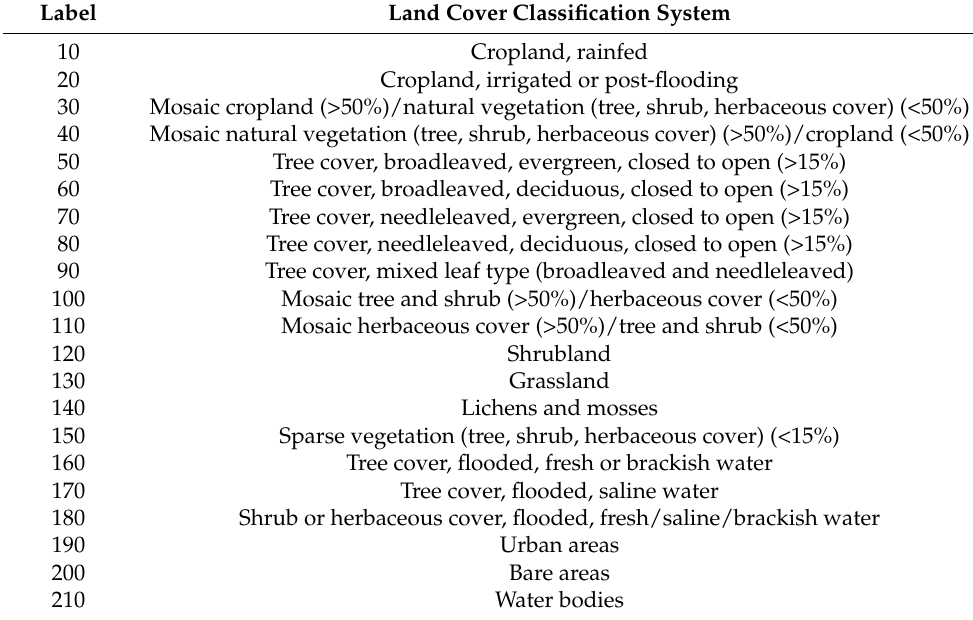
Table 2. Labels of the Land Cover Classification System (LCCS) [40] for the legend of Figure 3.